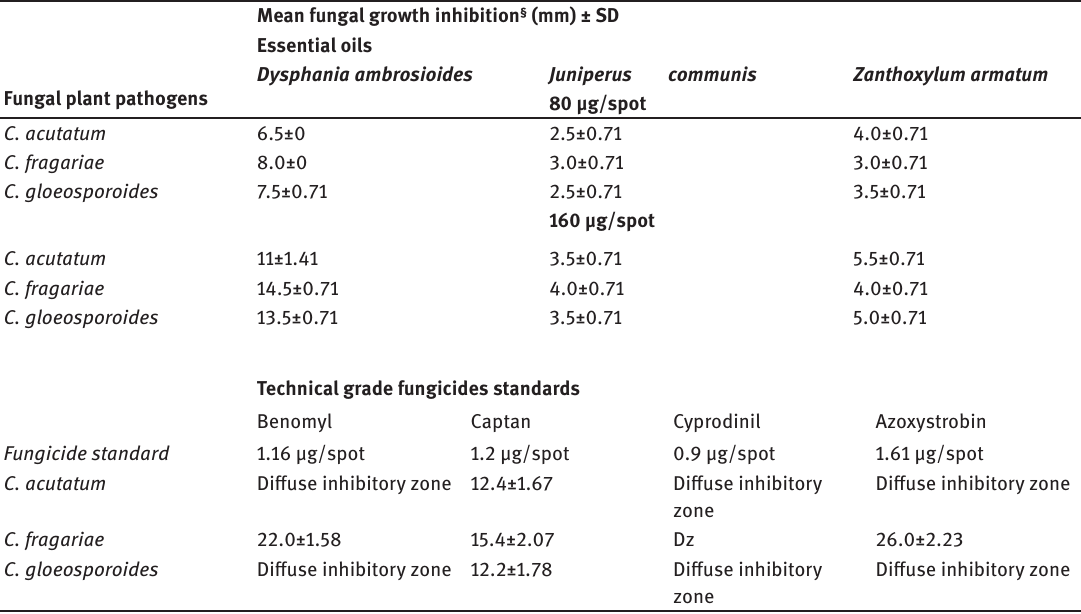
Table 4: Antifungal activity of three Himalayan essential oils against Colletotrichum test species using direct bioautography.